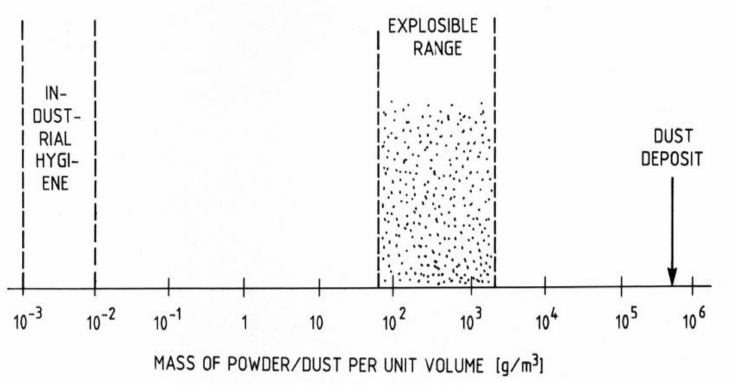
Figure 2. The range of explosible dust concentrations in air at normal temperature and atmospheric pressure for a typical natural organic dust (maize starch). A comparison with typical range of maximum permissible dust concentrations in the context of industrial hygiene, and a typical density of deposits of natural organic dusts. From Eckhoff [1–3]. Copyright (2019), with permission from